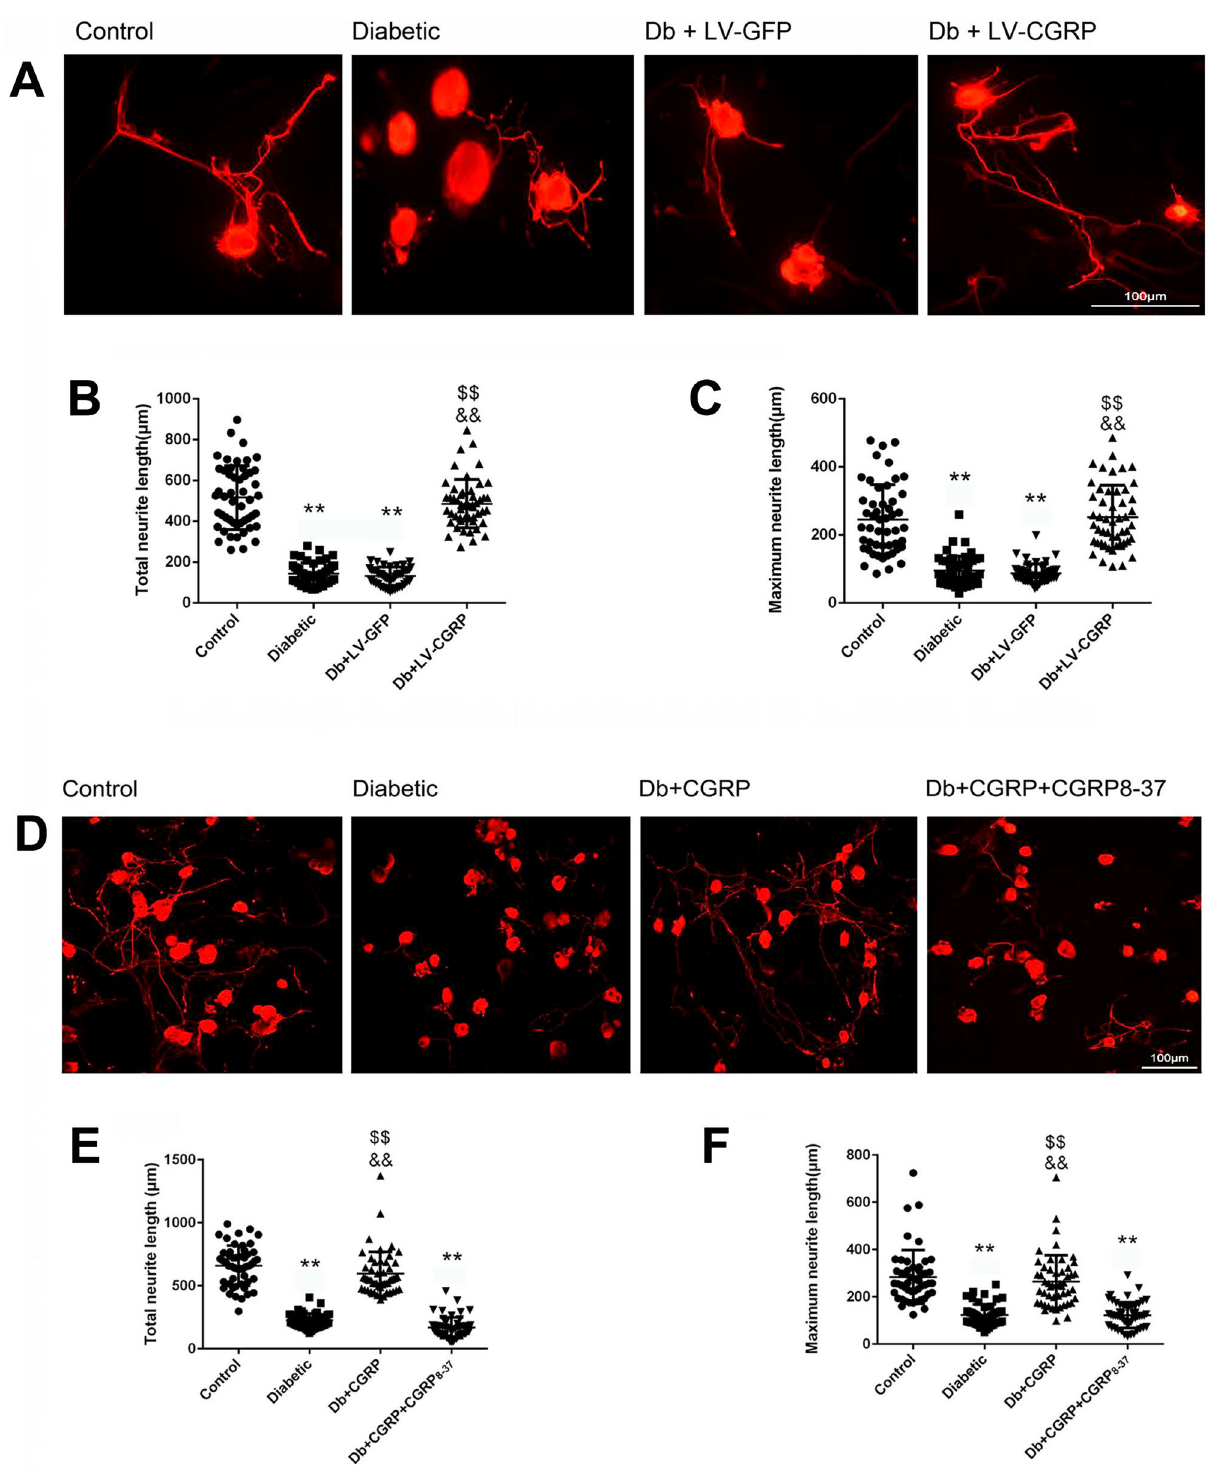
Figure 7. Transfection of LV-CGRP and exogenous CGRP promoted outgrowth of the neurites of the DRG neurons from the diabetic animals. ( A ) The representative images of outgrowth of the neurites of the dissociated DRG neurons from the age matched non-diabetic animals (Control), the neurons of diabetic animals without transfection of vectors (Diabetic), the neurons of diabetic animals transfected by LV-GFP (Db + LV-GFP) and by CGRP genes (Db + LV-CGRP). ( B ) Transfection of LV-CGRP fully corrected the impairment in the outgrowth of the neurites of the neurons from diabetic animals, evaluated as total neurite length ( B ) and maximum neurite length ( C ). The representative images of outgrowth of the neurites of the neurons from the non-diabetic and diabetic animals were shown in ( D ), indicate an effectiveness of CGRP (at 10 −8 mol/L, the final concentration) on promotion of the outgrowth of the neurites of the neurons from the diabetic animals ( D – F ). CGRP 8–37 completely abolished the protective effects of CGRP, suggests the specific receptor mediated the promoting actions of CGRP. ** p < 0.01, compared to the control; $$ p < 0.01, compared to Diabetic group; && p < 0.01, compared to Db + LV-GFP group or Db + CGRP + CGRP 8–37 group. The scales = 100